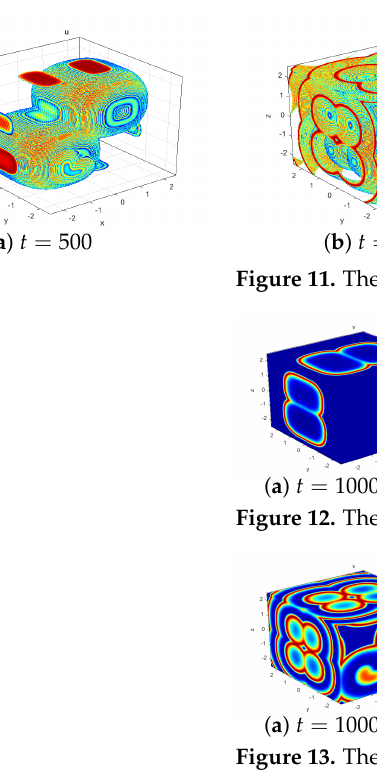
Figure 12. The patterns of v at K u = 1 × 10 − 4 , ε = 0.0001, µ = 0.01, β = 0.5, N = 512, and α = 1.8.